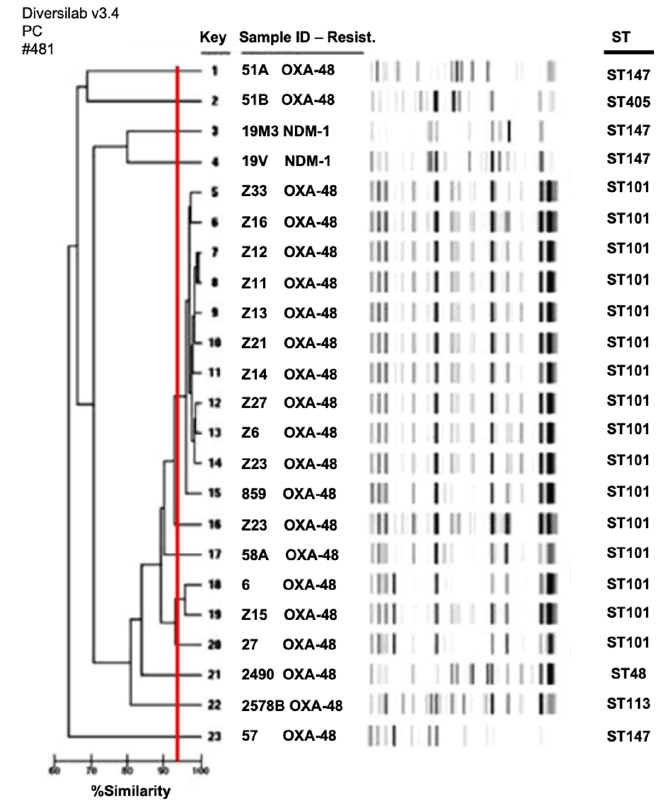
Figure 1. Dendrogram of NDM-1- and OXA-48-producing Klebsiella pneumoniae isolates. Red line corresponds to the limit of the clonality recommended by the manufacturer.